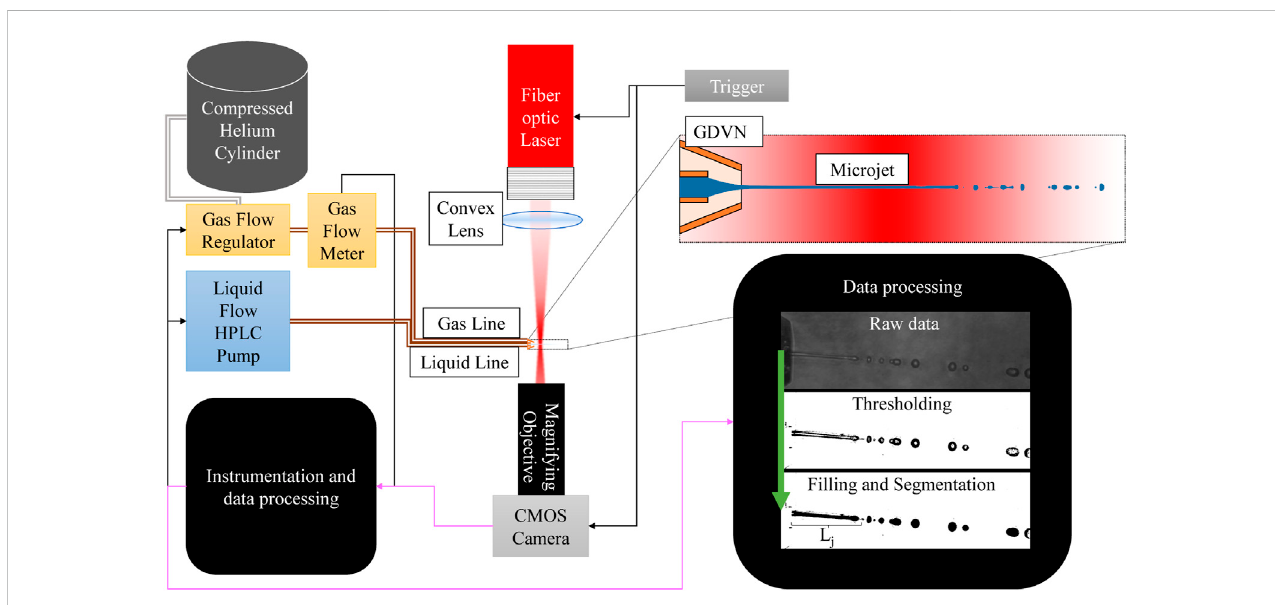
FIGURE 12 Schematic of the microjet imaging setup. The double lines represent fl uid fl ow, black lines represent electronic communications, and magenta lines represent image data. The gas fl ow regulator/meter controls the mass fl ow rate of helium to the GDVN. The HPLC pump controls the volumetric fl ow rate of the liquid to the GDVN. A fi ber-coupled nanosecond laser is focused near the GDVN, which is imaged using a CMOS camera. The data processing steps illustrated in the black box include image fi ltering, thresholding, and segmentation.